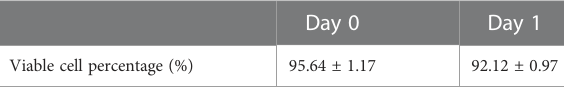
TABLE 2 Percentages of viable CD14 - PBMCs after